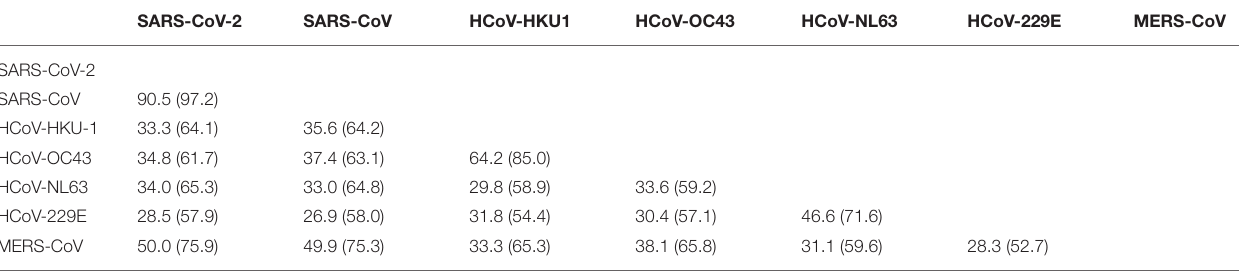
TABLE 1 | Identity and similarity score among virus N proteins.